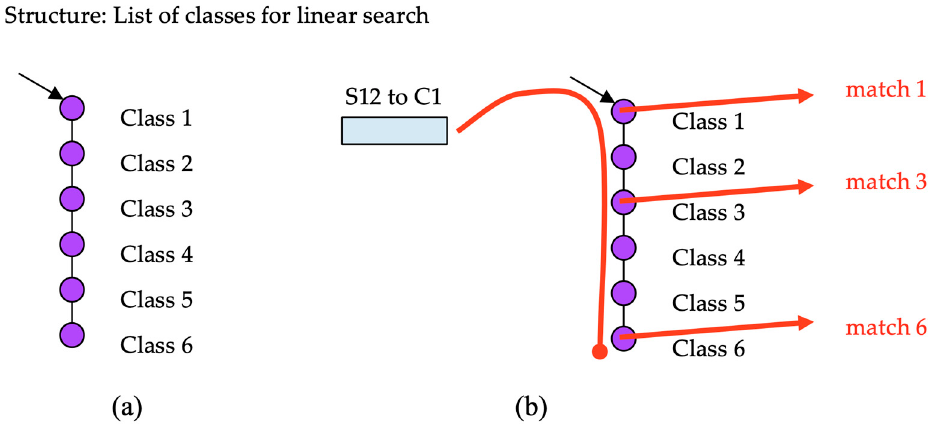
Figure 3. ( a ) Data structures and ( b ) search procedure in linear search (LS).